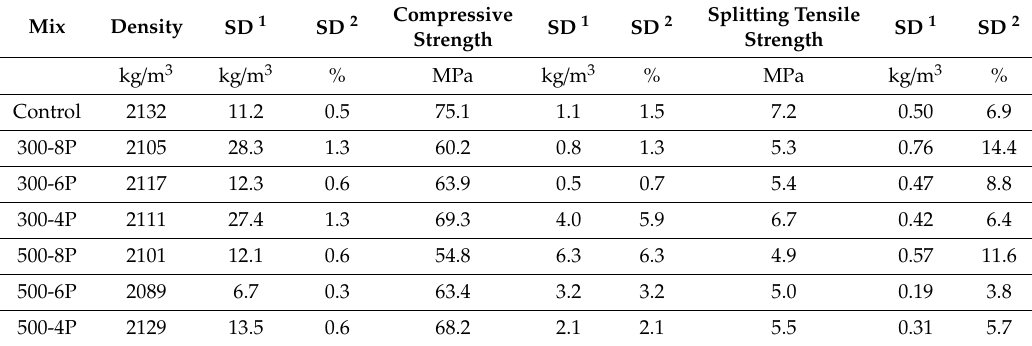
Table 3. Physical and mechanical properties of the Bamboo Fiber-reinforced mortar